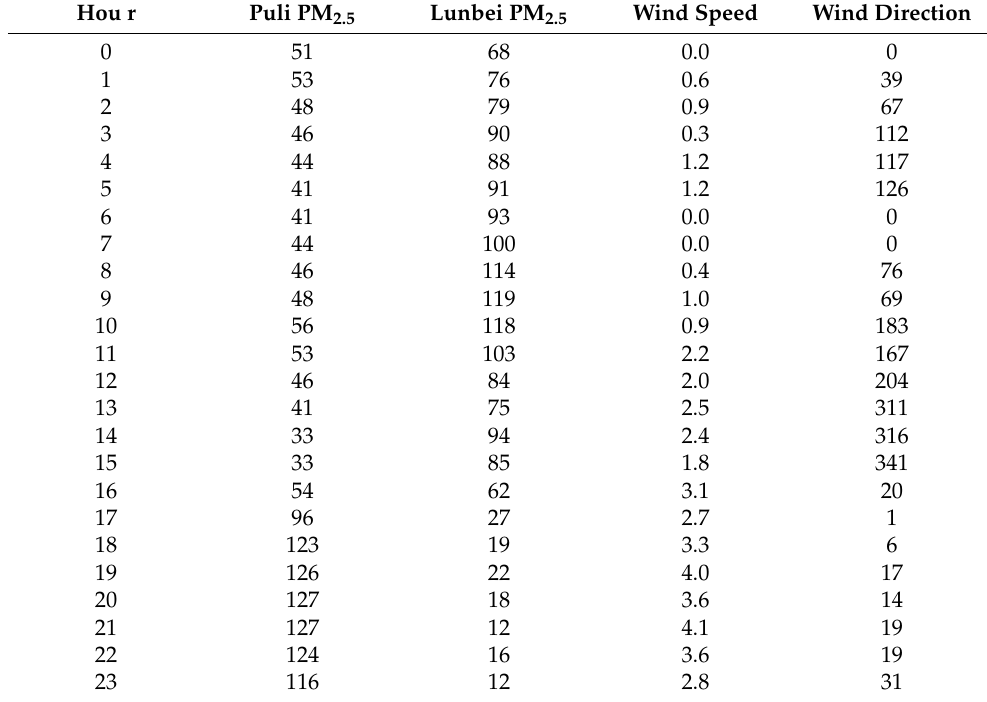
Table 5. Relationship between pollution events in Puli and